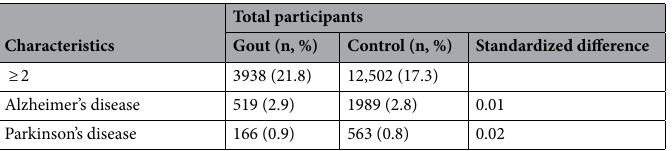
Table 1. General characteristics of participants. † Obesity (BMI, body mass index, kg/m 2 ) was categorized as < 18.5 (underweight), ≥ 18.5 to < 23 (normal), ≥ 23 to < 25 (overweight), ≥ 25 to < 30 (obese I), and ≥ 30 (obese